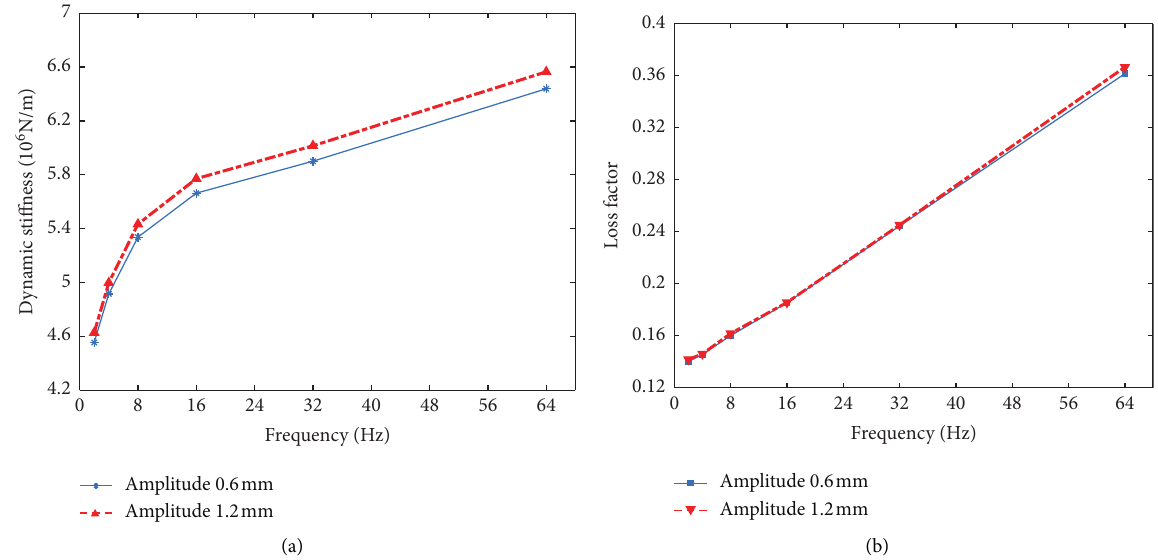
Figure 23: The influence of frequency on dynamic characteristics of shaft damping ring under different amplitudes. (a) The influence of frequency on dynamic stiffness. (b) The influence of frequency on loss factor.